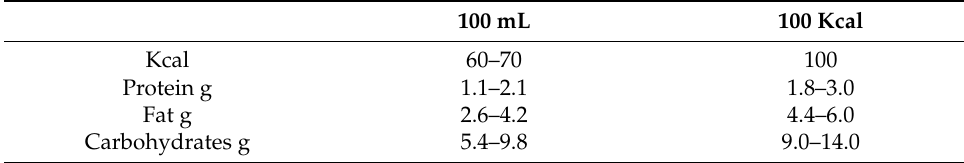
Table 2. Compositional requirements for infant formula based on cows’ milk